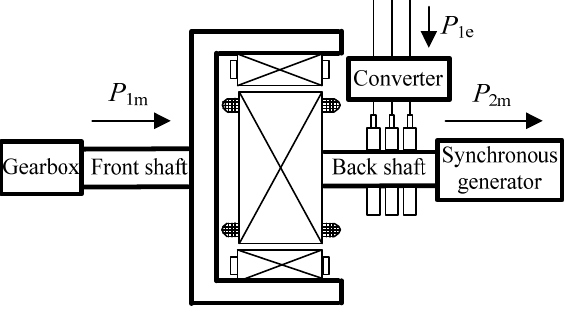
Figure 1. Schematic diagram of the electromagnetic coupling speed regulating device’s (EMCD) typical